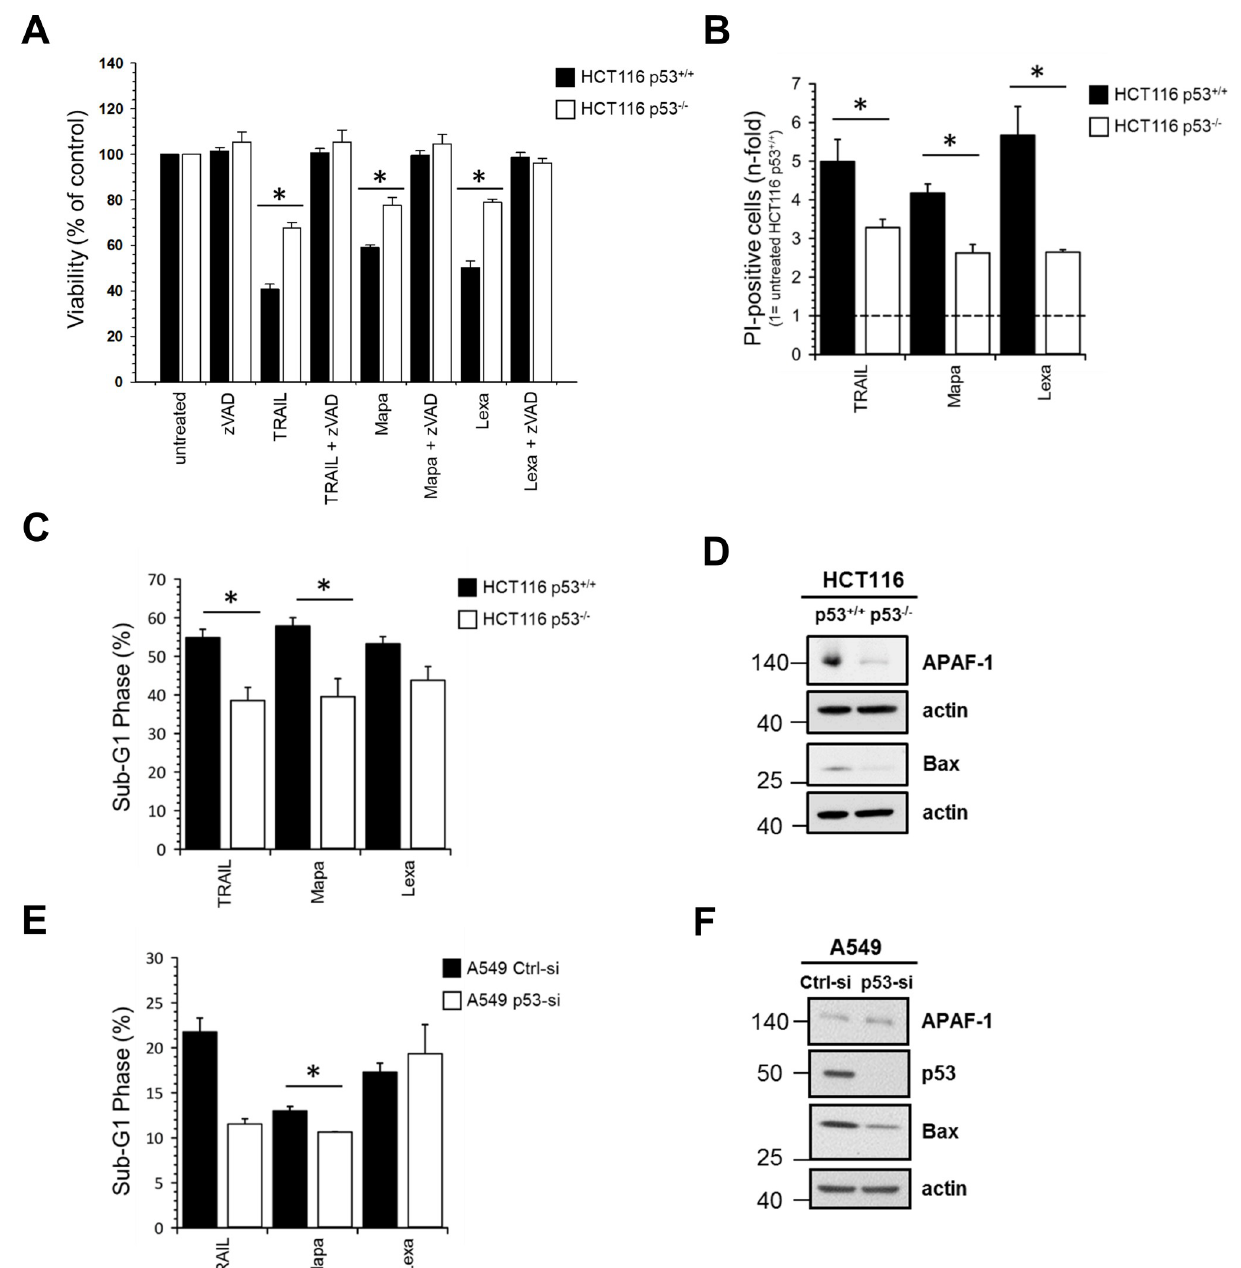
Fig 2. Inhibition of p53 expression decreases TRAIL receptor-induced apoptosis. HCT116 p53 +/+ and HCT116 p53 -/- cells were stimulated either with TRAIL (100 ng/ml), Mapatumumab (10 μ g/ml) or Lexatumumab (10 μ g/ml) for 24 h with or without zVAD-fmk. Cell viability was determined by crystal violet staining (A) or by PI-staining followed by flow cytometry (B). In addition, DNA-fragmentation assay was performed with HCT116 p53 +/+ and HCT116 p53 -/- (C) and A549 cells with and without transient knockdown of p53 (E). Results are shown ± SD of three biological replicates (n = 3) (A-C) or ± SD of two to three biological replicates (n = 2–3) (E). � p < 0.05. Impact of p53 expression on the cellular levels of APAF-1 and Bax was analyzed in whole cell lysates of HCT116 cells (D) and A549 (F) by Western blot. The level of actin was determined in parallel and served as loading